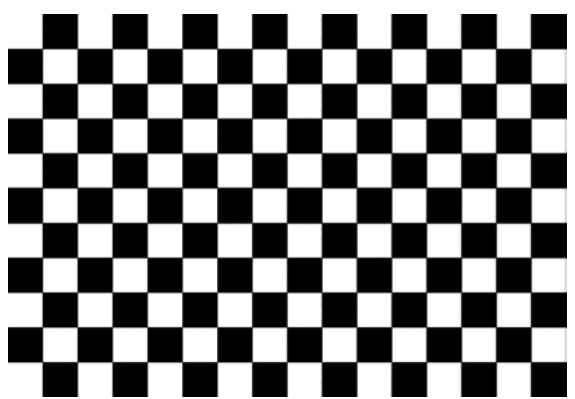
Fig. 1. Agisoft Lens calibration field